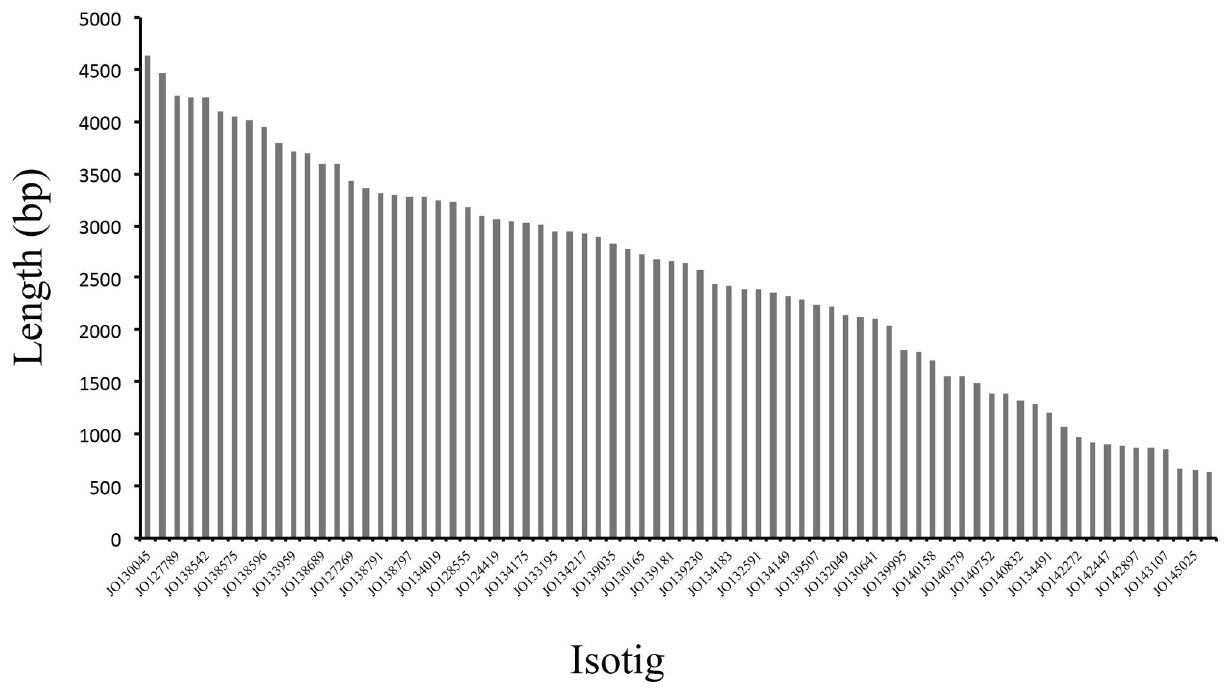
Figure 5. Isotig size distribution for immunity related genes in Cape